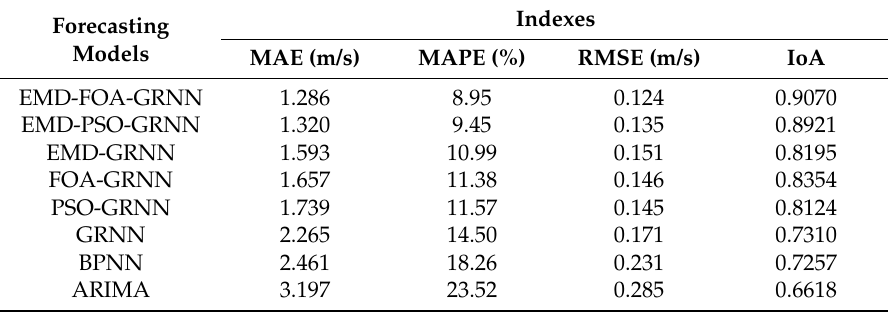
Table 4. Statistical error measures of prediction methods in Case One.